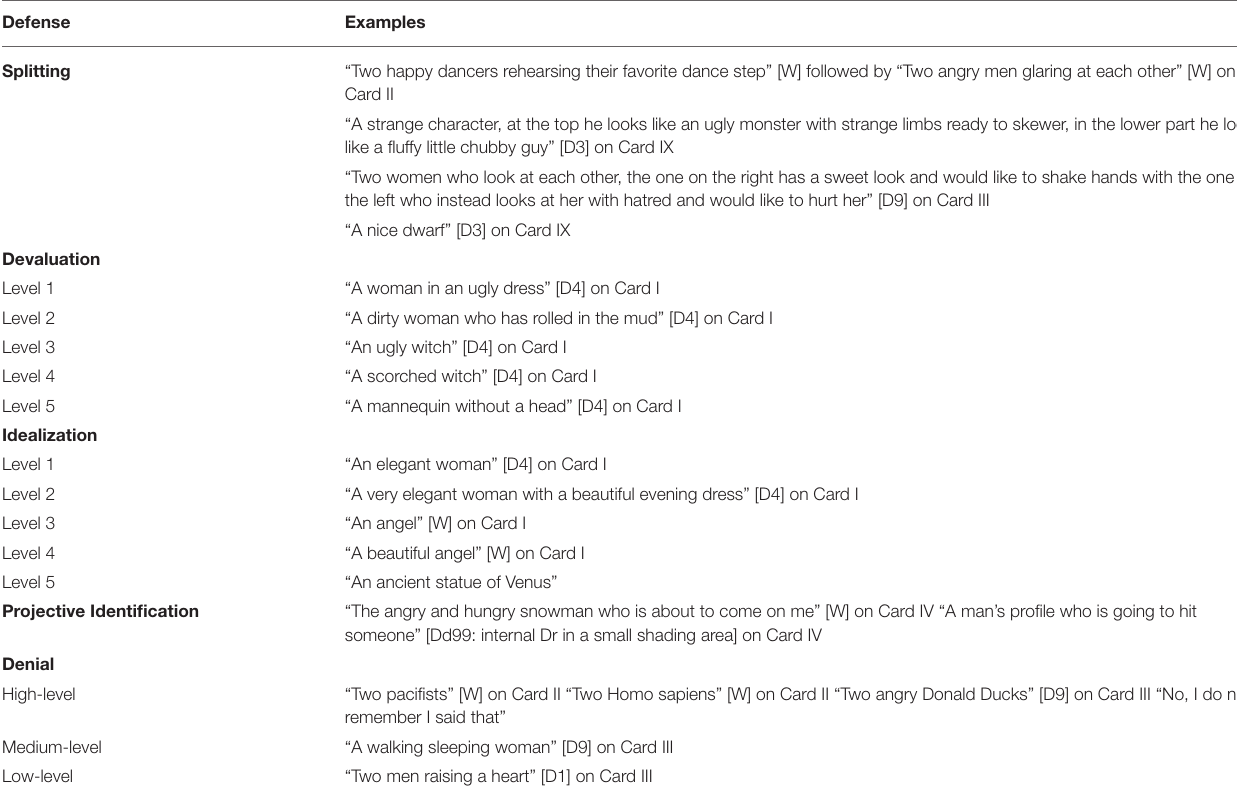
TABLE 1 | Examples of Rorschach responses coded according to Lerner Defense Scale (LDS) guidelines.